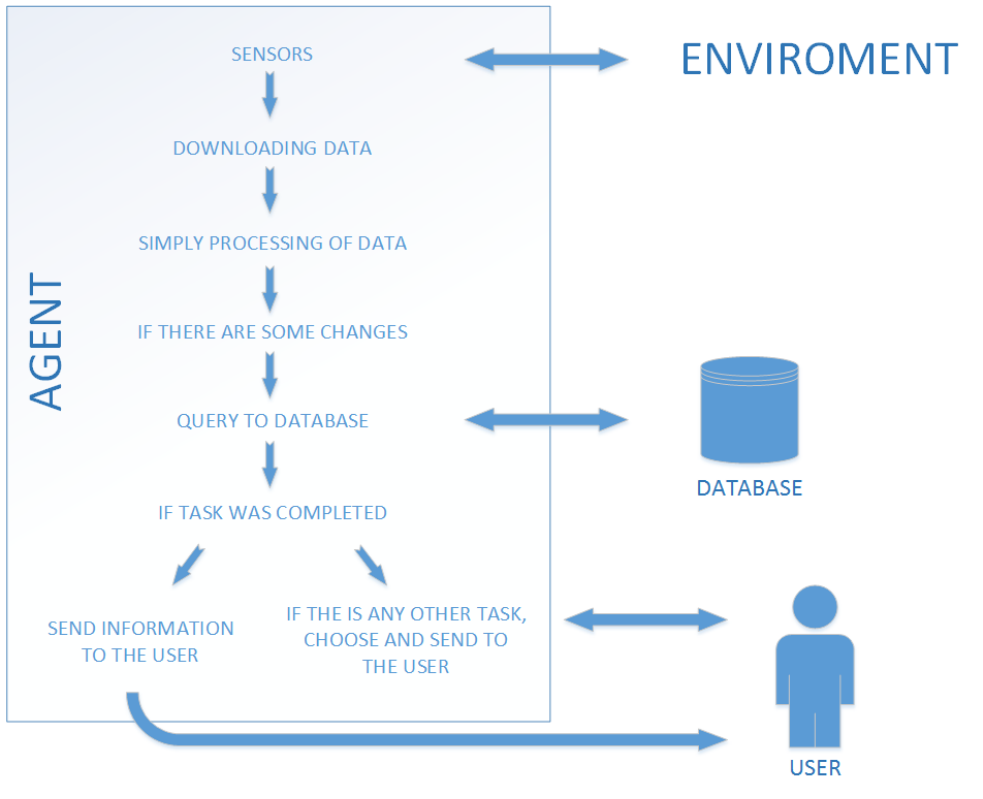
Figure 1. Agent architecture in the proposed